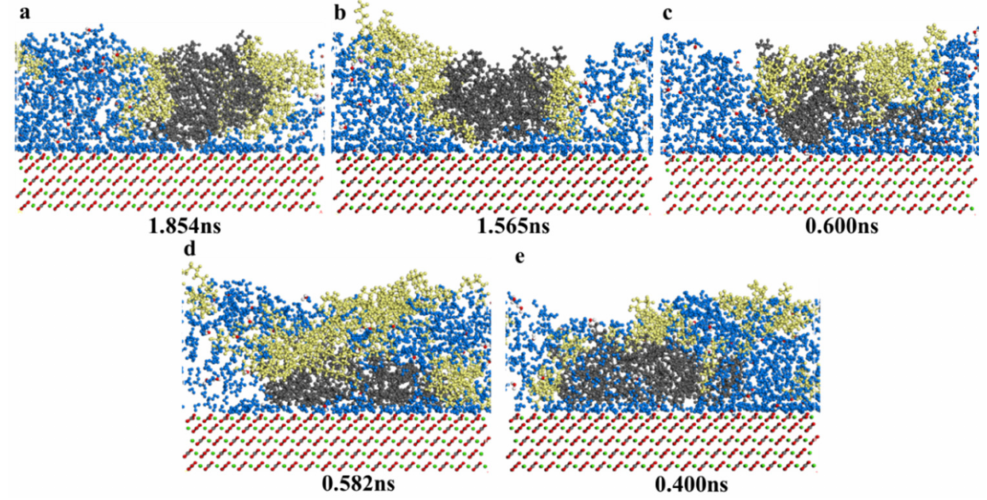
Figure 13. Consecutive snapshot of desorption of resins from a modeled calcite surface immersed in ( a ) CTAB; ( b ) SDS; ( c ) TX-100; ( d ) Sophorolipid; ( e ) Rhamnolipid-water system just right. Blue = water; black = resins; red = calcite surface; yellow =